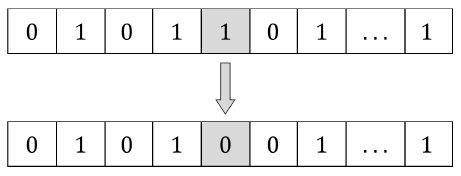
Figure 3. Swap: a symbolic term is randomly selected and inverted.